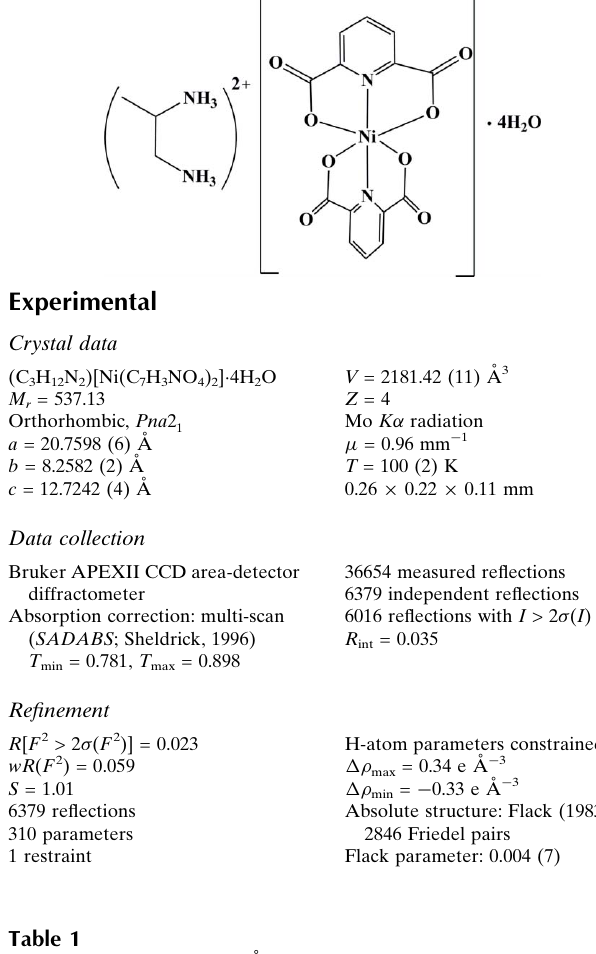
Hydrogen-bond geometry (A˚ , (cid:3) ). D —H (cid:1)(cid:1)(cid:1)